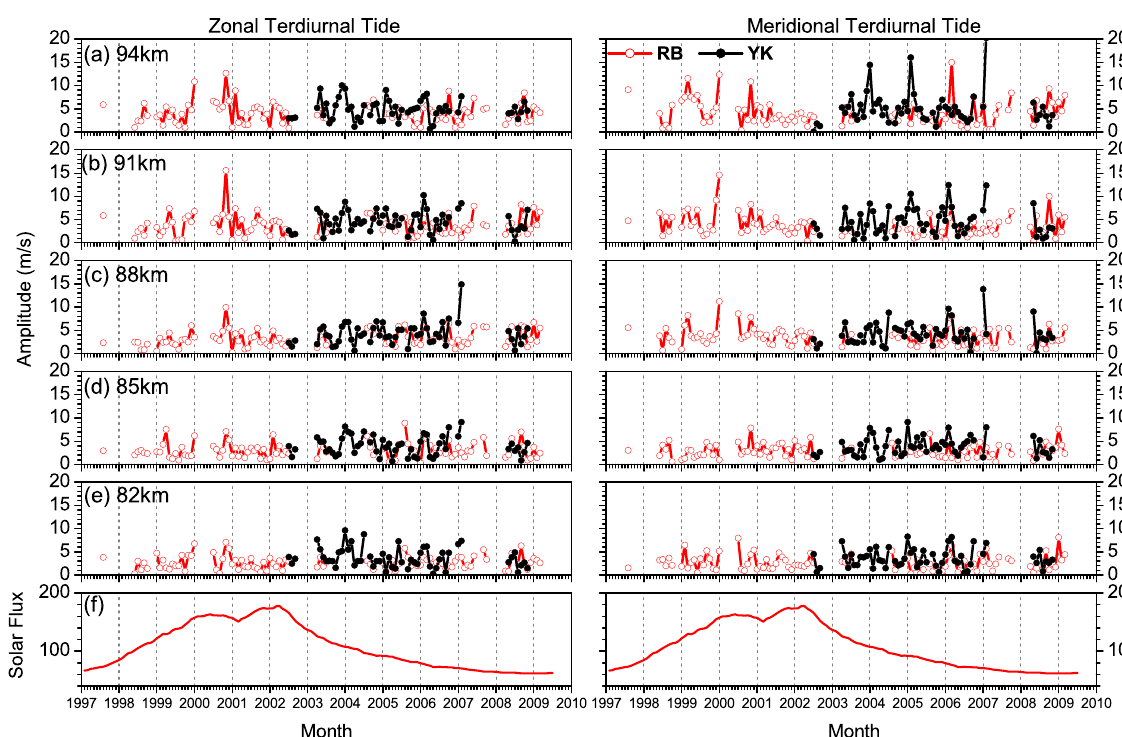
Fig. 7. Similar to Fig. 3, but for terdiurnal tidal